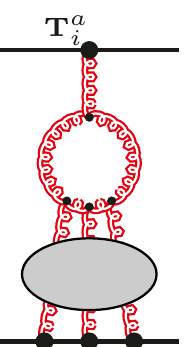
Figure 8. Diagrammatic representation of a generic transition amplitude connecting one- and three-Reggeon